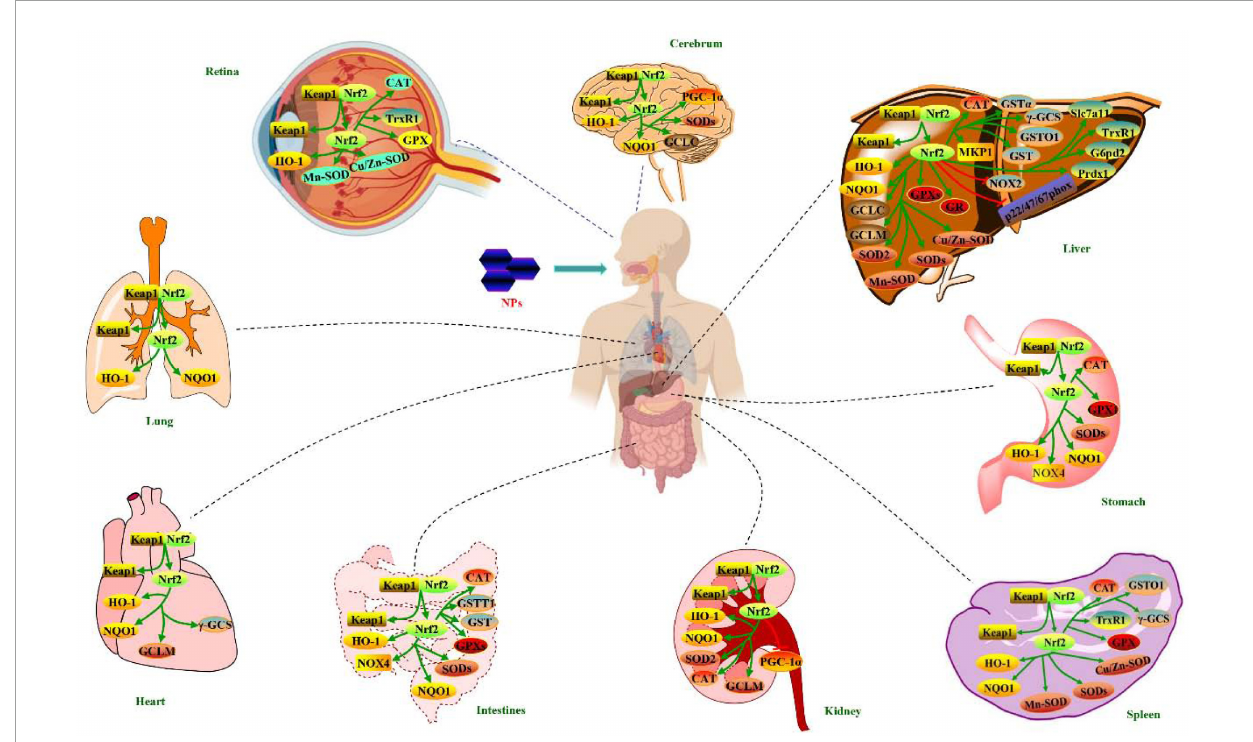
FIGURE3 Regulations of NPs on Nrf2 antioxidant pathway in health-promoting effects in vivo .